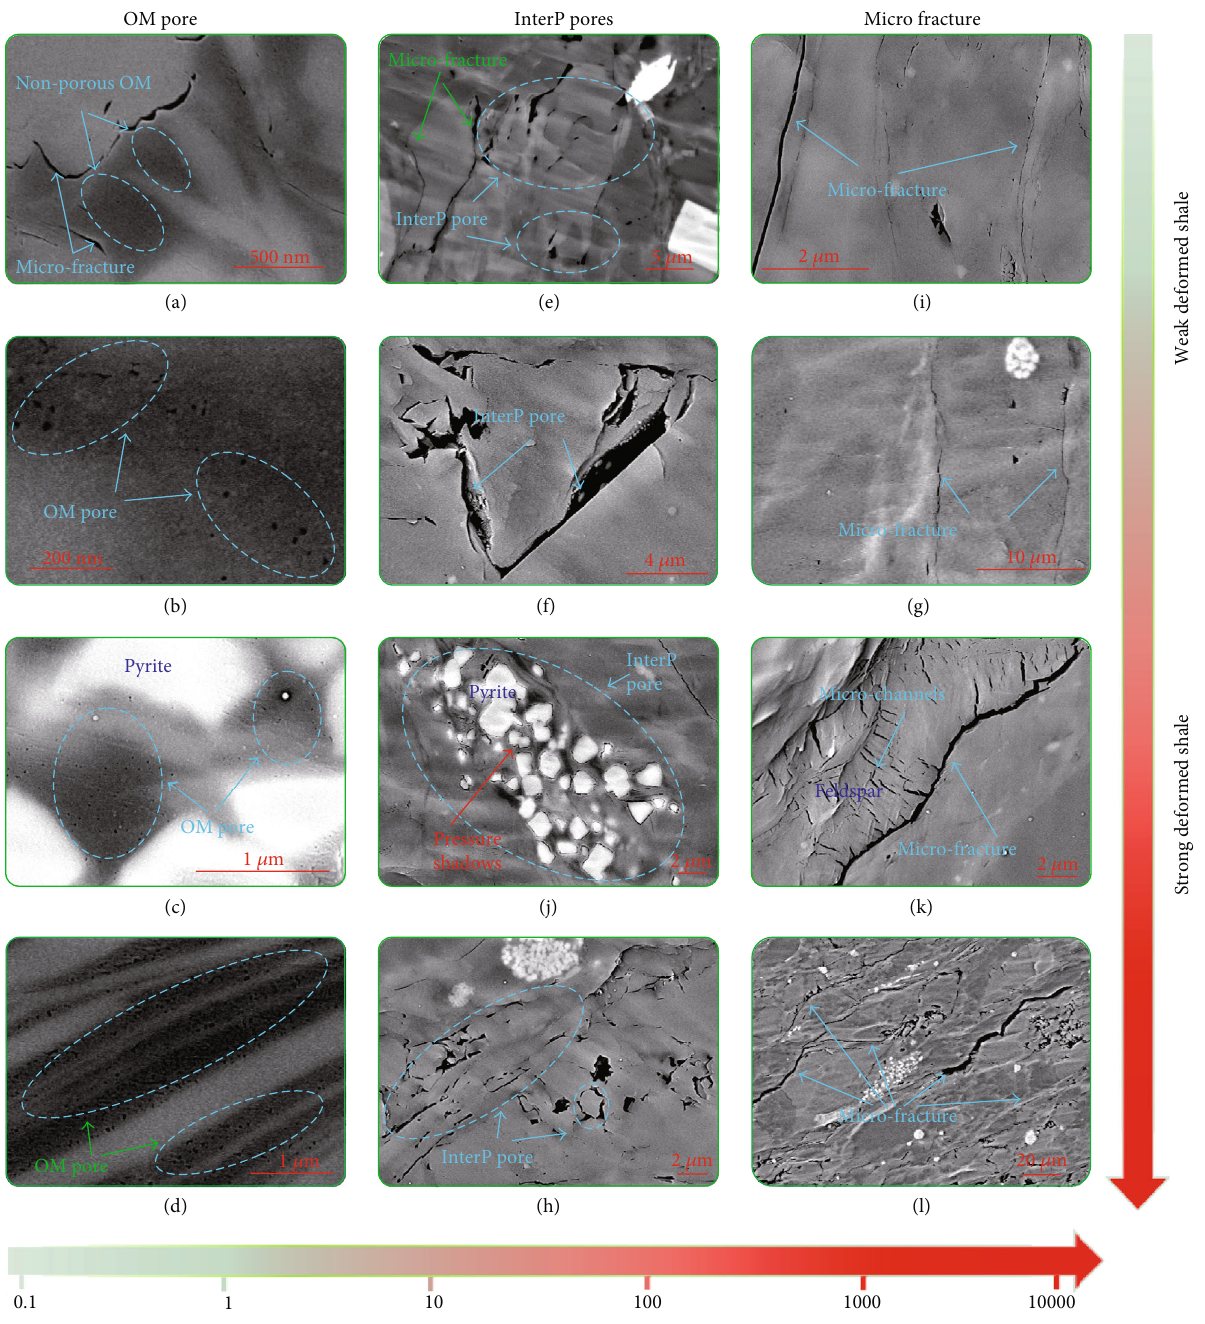
Figure 6: Example of pores within the Lujiaping shale. (a, b) SEM images show that most samples contain few OM pores. (c) OM between pyrite grain has more organic pores. (d) The OM-clay aggregate in the strong deformed samples contains some organic pores. (e) Triangular interP pores occur on the edge of rigid grains. (f) InterP pores around the rigid grains. (j) InterP pores between pyrite grain and OM and clay. (h) Long strip-shaped interP pore around the rigid grains. (i, g) Microfractures developed around minerals are generally small. (k) Microchannels occur mostly inside the grain and perpendicular to the edges of the particles, while microfractures are mostly along the edges of the particles. (l) Microchannels and microfractures related to deformation, and the size is relatively